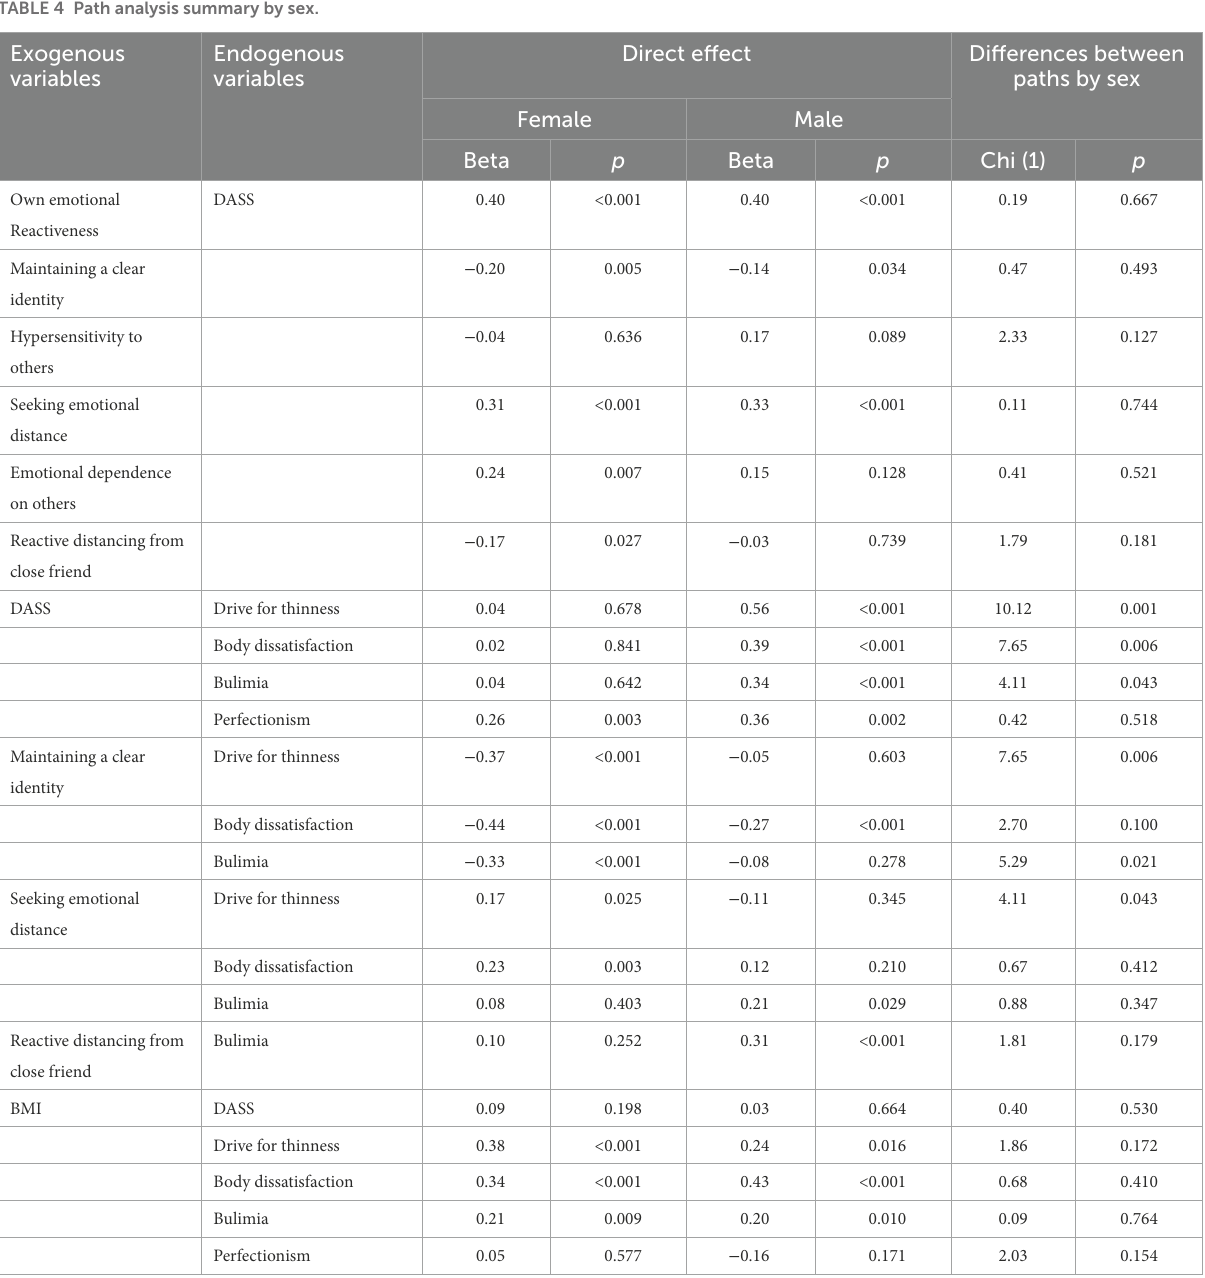
TABLE 4 Path analysis summary by